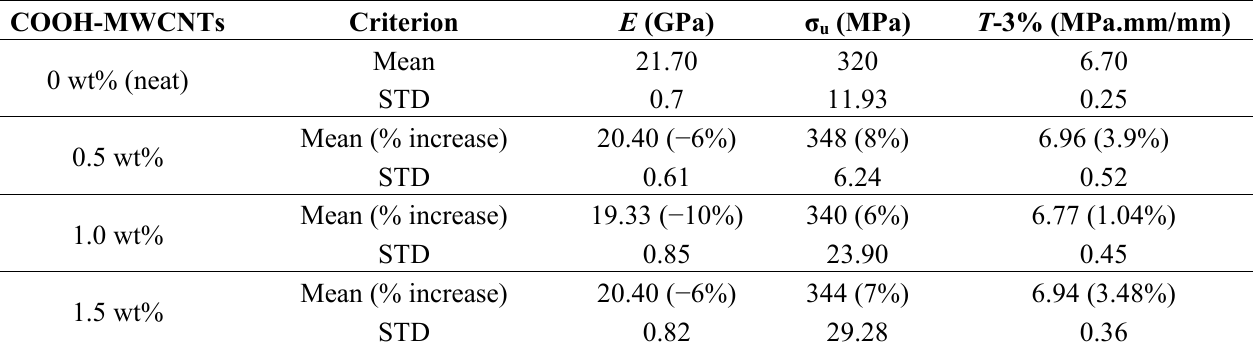
Table 2. Statistical analyses for the on-axis flexure test with various COOH-MWCNTs loadings: flexure modulus of elasticity ( E ), flexure strength (σ the 3% strain level ( T -3%).